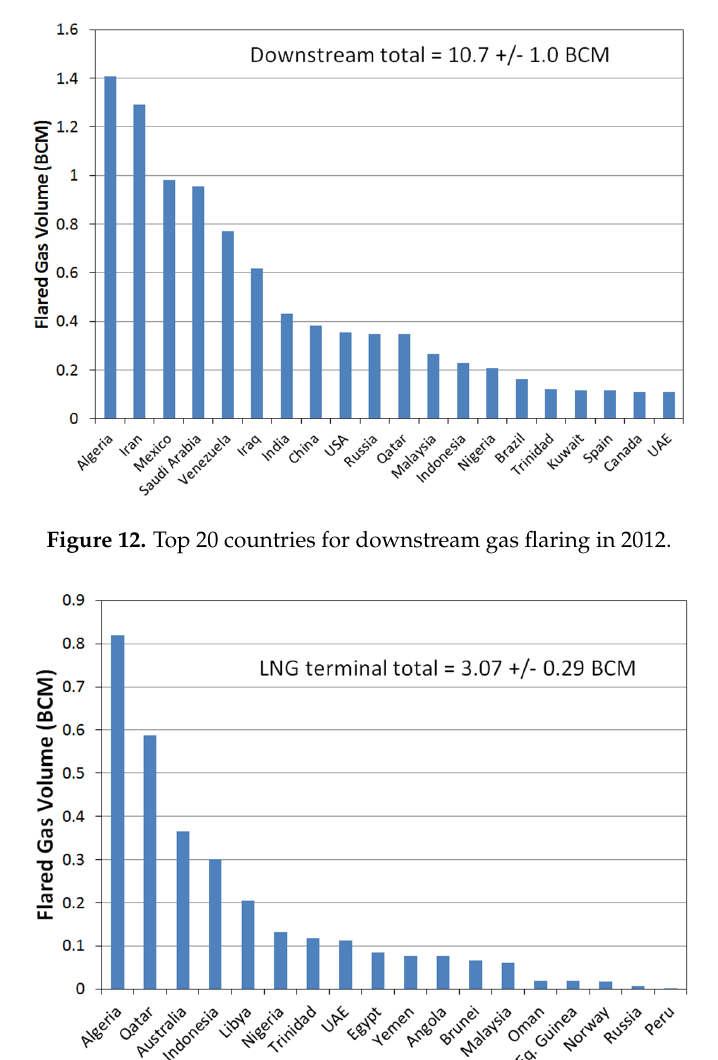
Figure 11. Top 20 countries for upstream gas flaring in 2012. Energies 2016 , 9 , 14